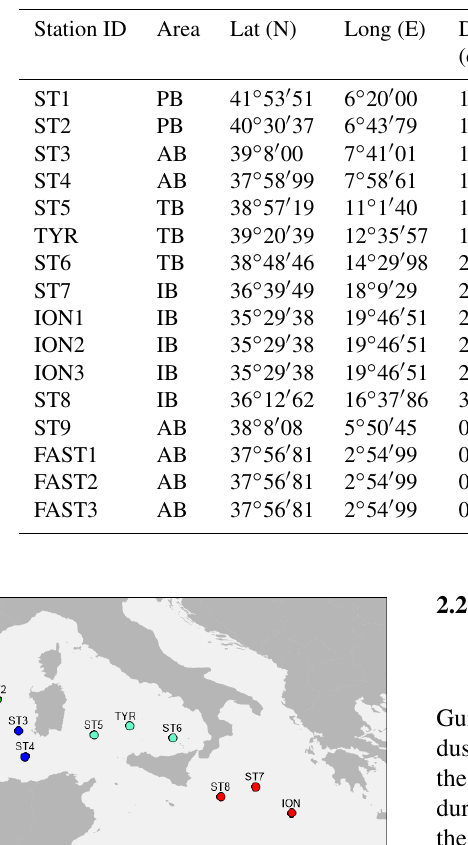
Table 1. Stations sampled during the PEACETIME survey: geographical information, date, and time of zooplankton net sampling. AB refers to the Algerian Basin, PB refers to the Provencal Basin, TB refers to the Tyrrhenian Basin, and IB refers to the Ionian Basin.